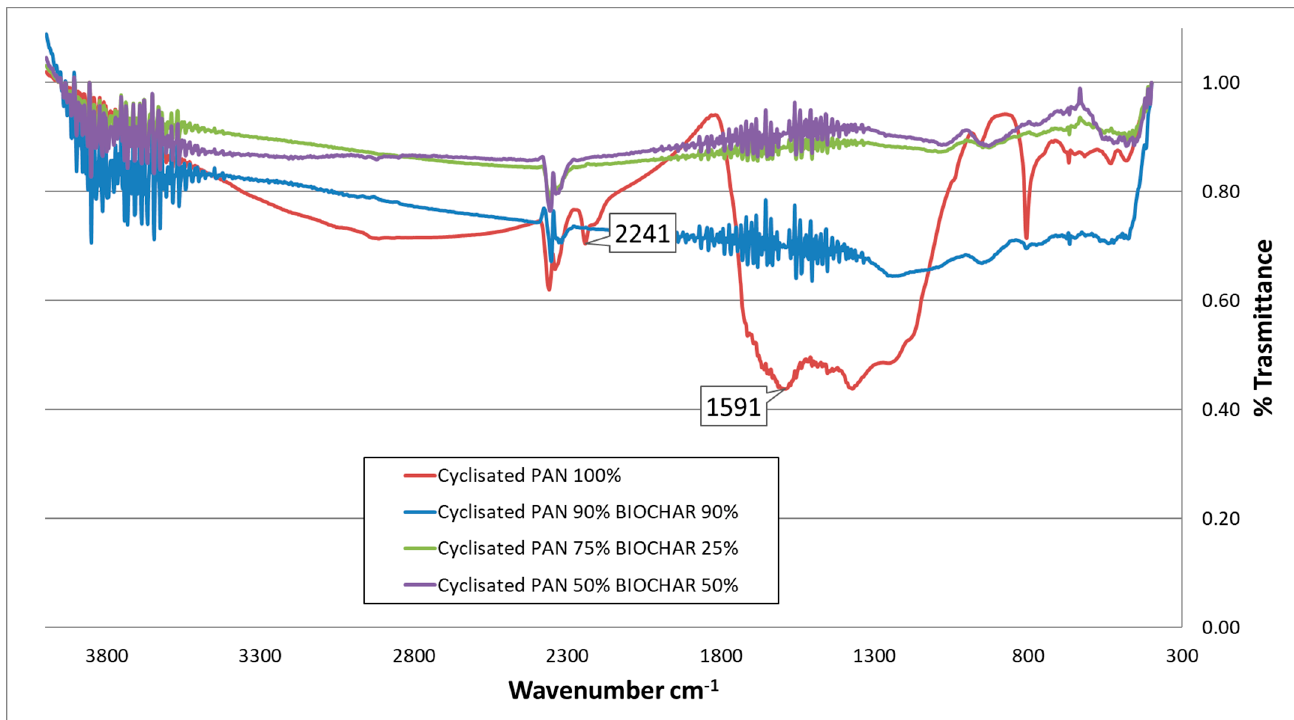
Figure 10. IR spectra of “cyclized” fibers.